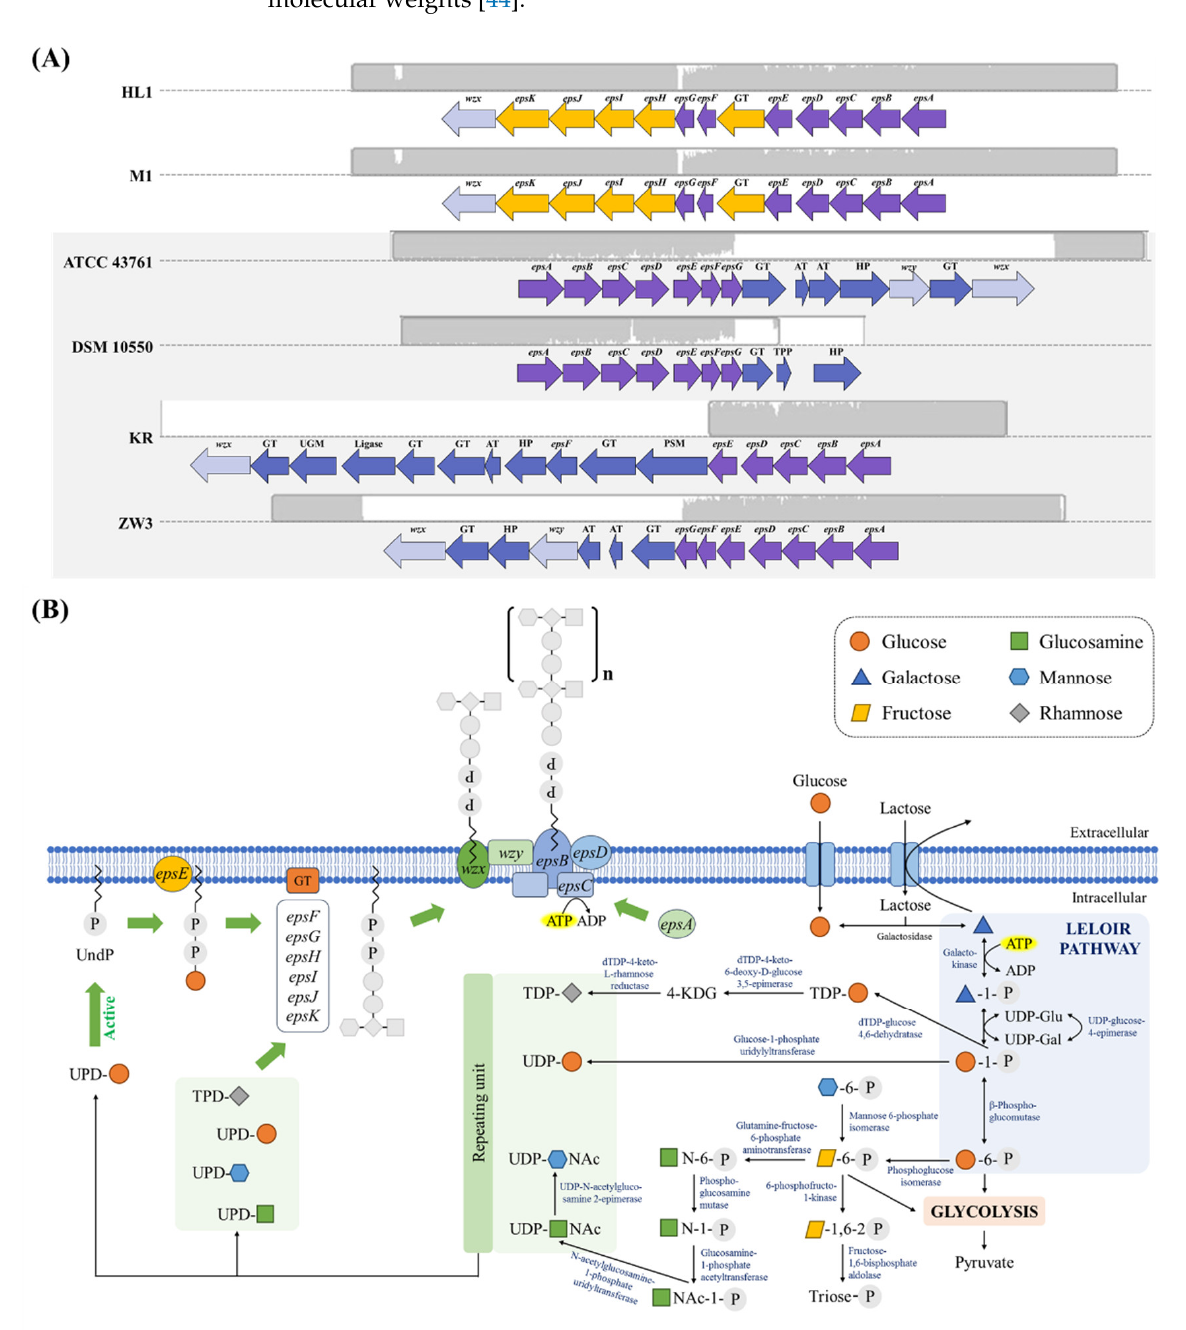
Figure 4. ( A ) Genetic organization of eps gene clusters in L. kefiranofaciens strains. Gene functional groups are marked with different colors. ( B ) Proposed biosynthesis pathway for the exopolysaccharide (EPS) production according to the Kyoto Encyclopedia of Genes and Genomes (KEGG) analy- sis.